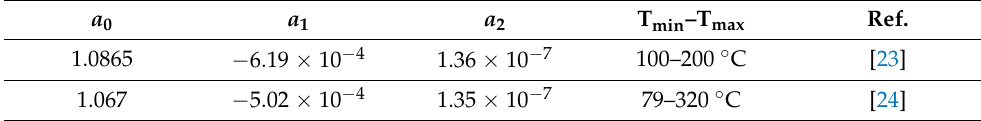
Table 2. Constants used in Equation (15) to calculate the density of PS at atmospheric